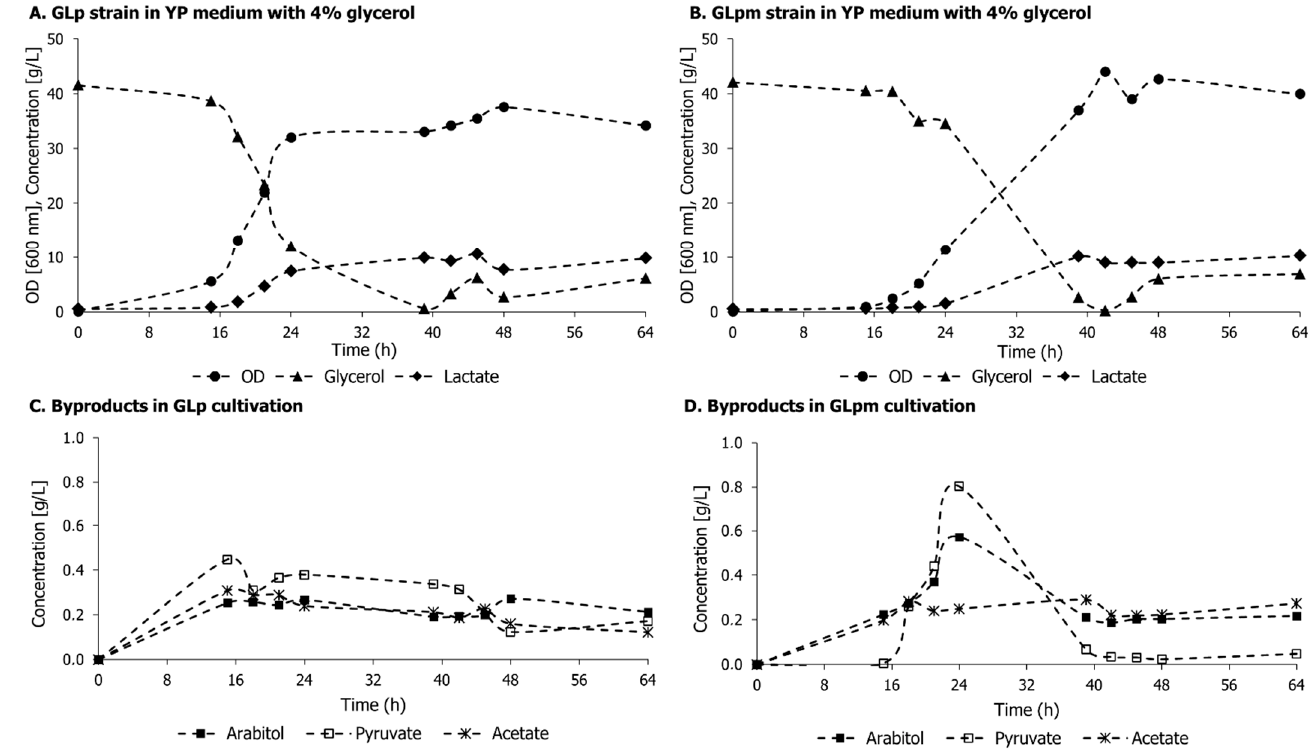
Figure 5. Growth curves, glycerol consumption, lactic acid production, and byproduct formation of GLp ( A , C ) and GLpm ( B , D ) strains in YP medium with 4% glycerol in the DASbox ® mini bioreactor system. Experiments were carried out in biological duplicates.